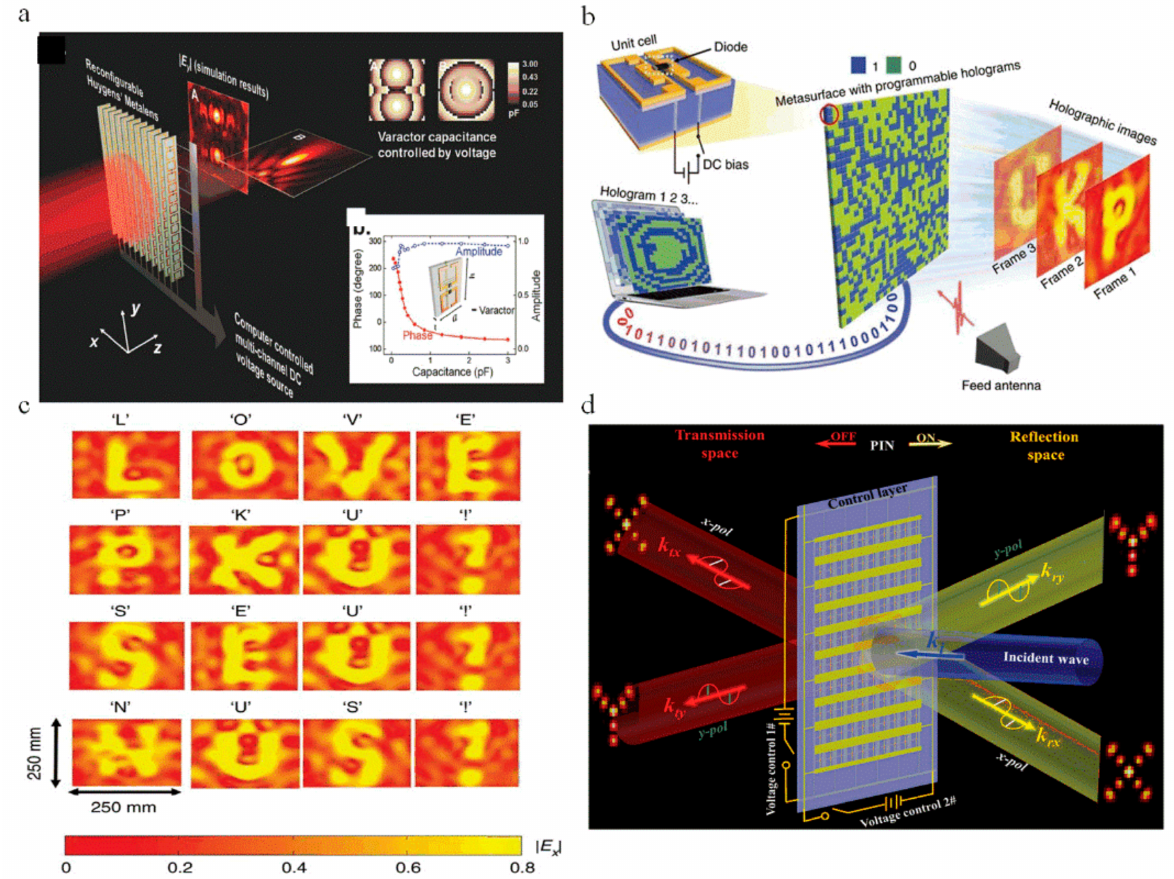
Figure 8. A variety of electrically reconfigurable metasurface designs. ( a ) Loaded with diodes for focal length control. Reprinted with permission from ref. [120]. Copyright 2017 John Wiley and Sons. ( b ) The schematic of a holographic imaging system based on microwave programmable coding metasurfaces. Reprinted with permission from ref. [122]. Copyright 2017 Springer Nature. ( c ) The experimental results of holograph images. Reprinted with permission from ref. [122]. Copyright 2017 Springer Nature. ( d ) Anisotropic digitally coded metasurface with the independent control of the transmission and reflection modes under x and y polarized incidence. Reprinted with permission from ref. [123]. Copyright 2020 John Wiley and